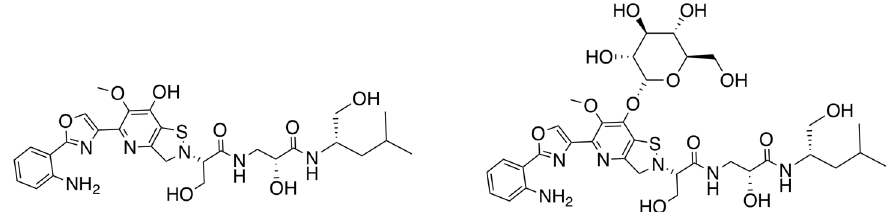
Figure 2. Structures of levesquamide A ( left ) and levesquamide B ( right ).